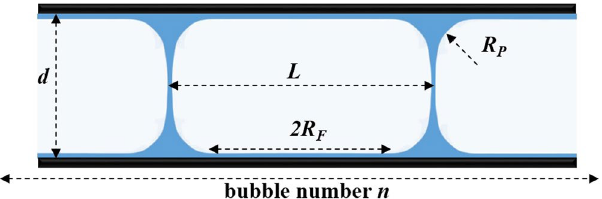
Figure 1. Schematic of foam (bamboo bubbles) in capillary tube ( d is the diameter of the capillary; L is the length of bubble; R F is half length of the wetting film and R p is the plateau border radius of